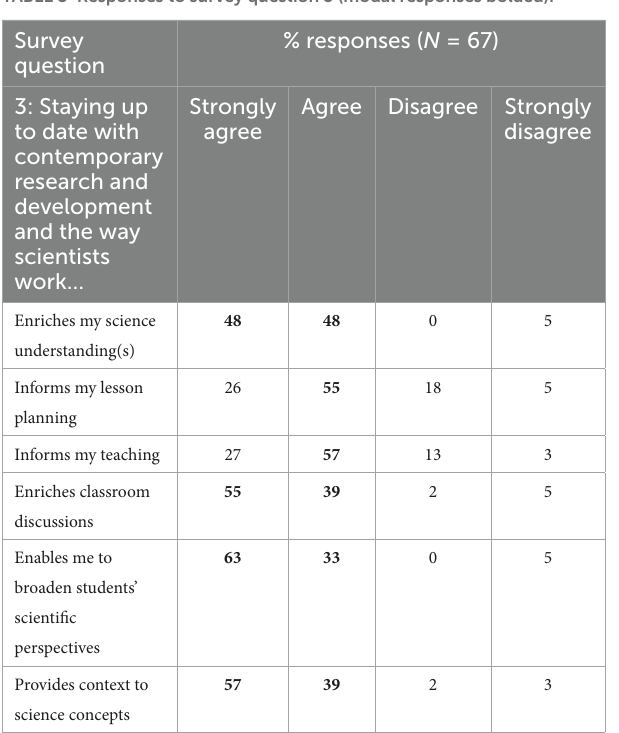
TABLE 3 Responses to survey question 3 (modal responses